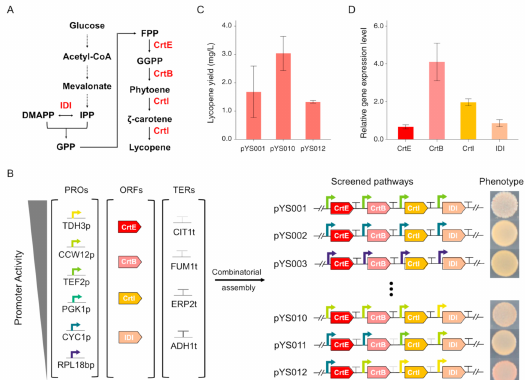
Figure 2. Lycopene biosynthesis pathway optimization by combinatorial assembly and screening. ( A ). Overview of lycopene biosynthesis pathway in S. cerevisiae . Key enzymes expressed for lycopene production are highlighted in red. ( B ). Schematic illustration of parts used for combinatorial assembly and assess their effects to lycopene production. ( C ). The lycopene yield of the strains hosting pYS001, pYS010, and pYS012 were measured by HPLC. ( D ). Evaluation of individual promoter strengths in strain YSy212 containing pYS010 plasmid by RT-PCR. Error bars indicate ± SD (n =